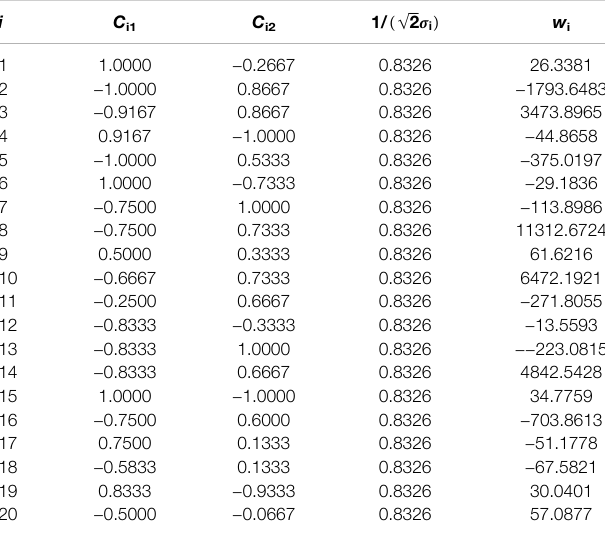
TABLE A1 | Neural network structure